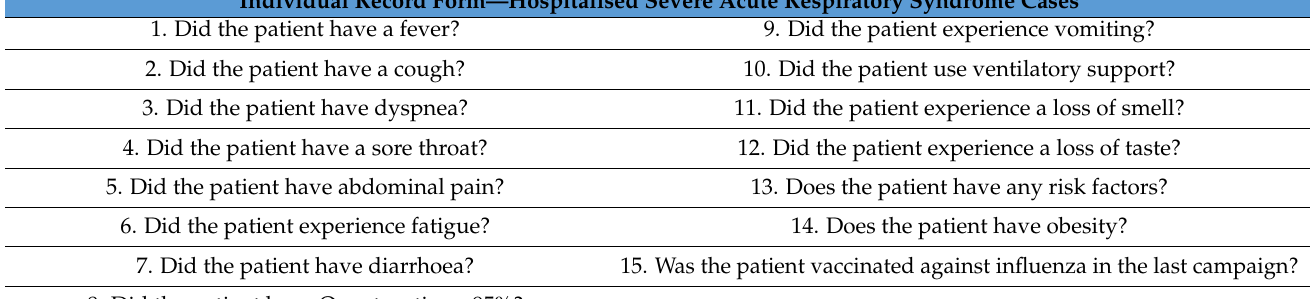
Table 11. Clinical questionnaire.